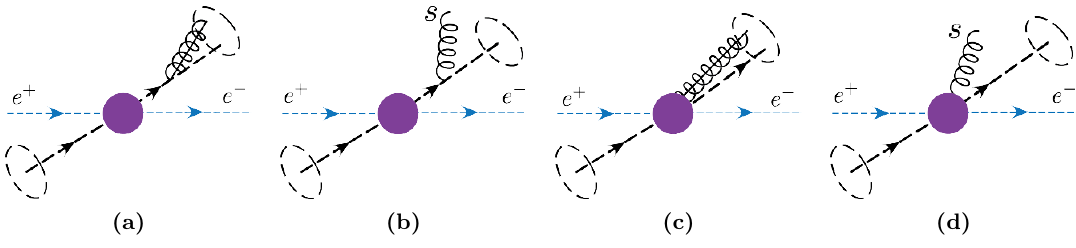
Figure 1. Examples of the contributions to thrust, (cid:28) , in the dijet limit, at leading power in (a) and (b), and subleading power in (c) and (d). There is an extra collinear gluon in (a) from splitting, and in (b) there is an extra gluon from soft emission. In (c) the extra energetic gluon is collinear with the quark, but occurs without a nearly onshell parent propagator. Likewise in (d) the extra soft emission amplitude is